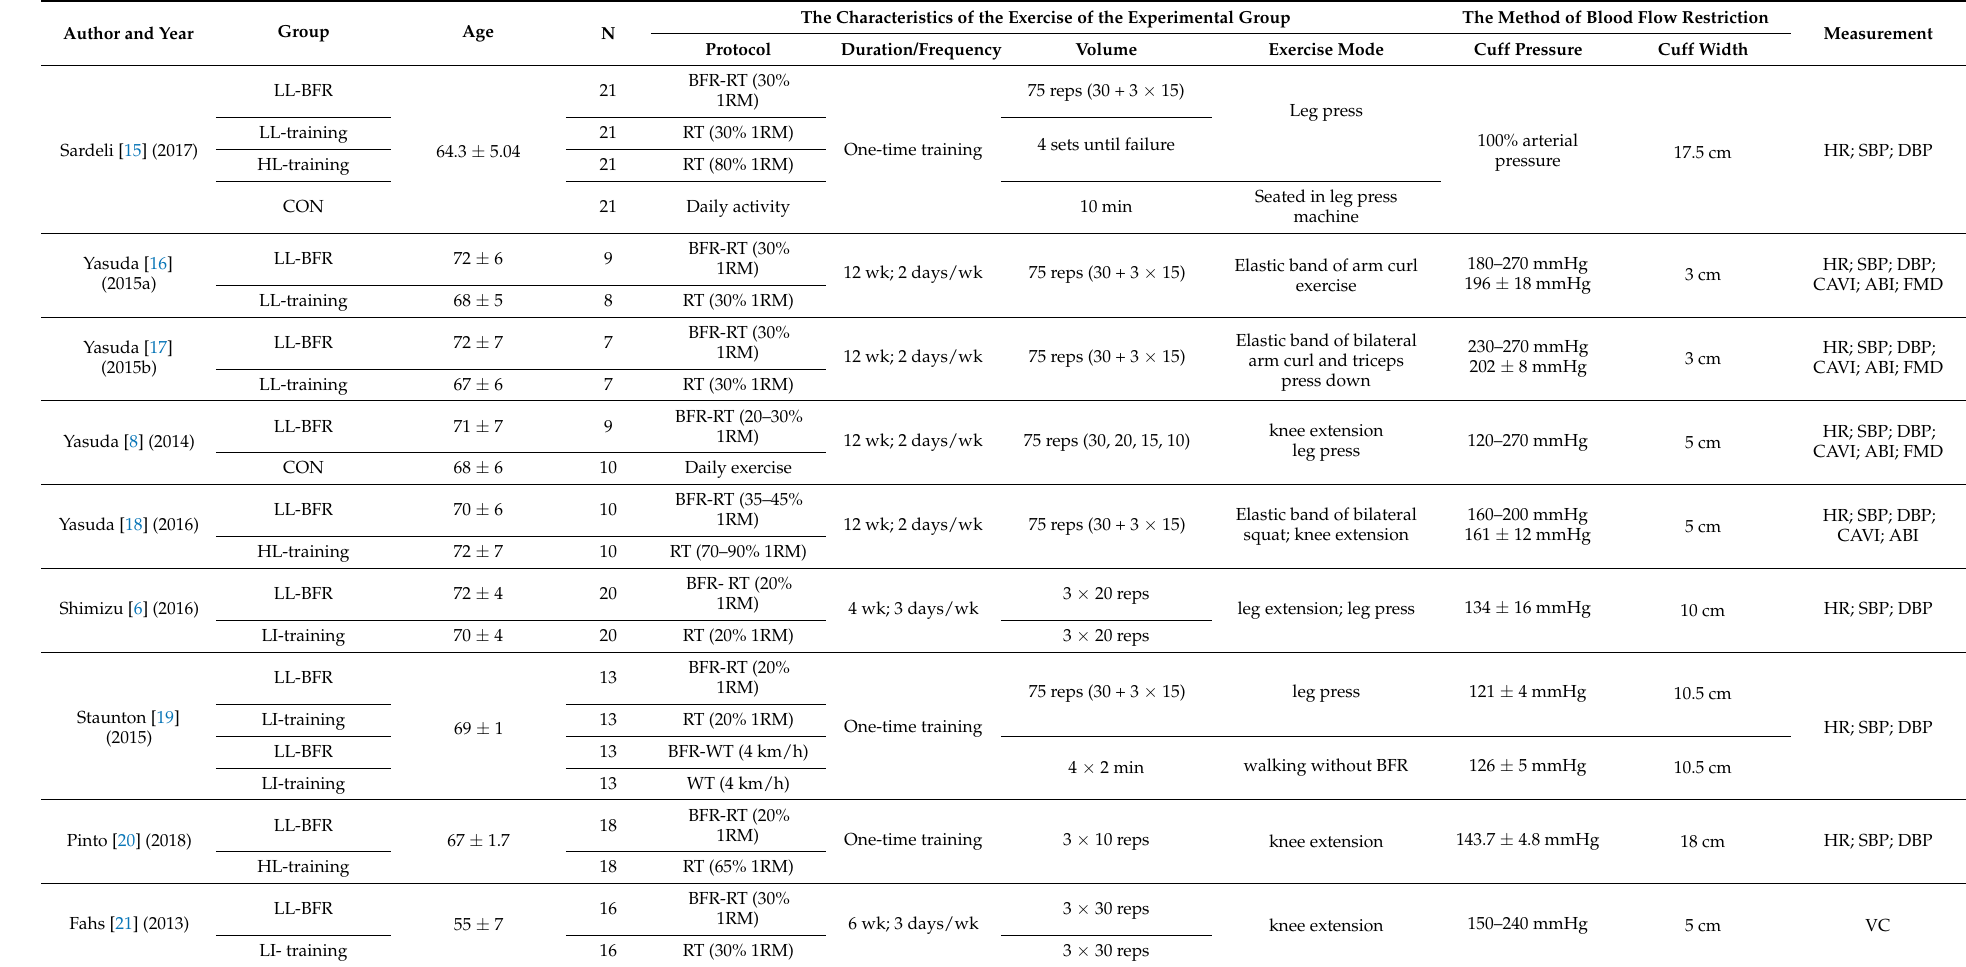
Table 1. Characteristics of participants, training protocol and BFR in studies